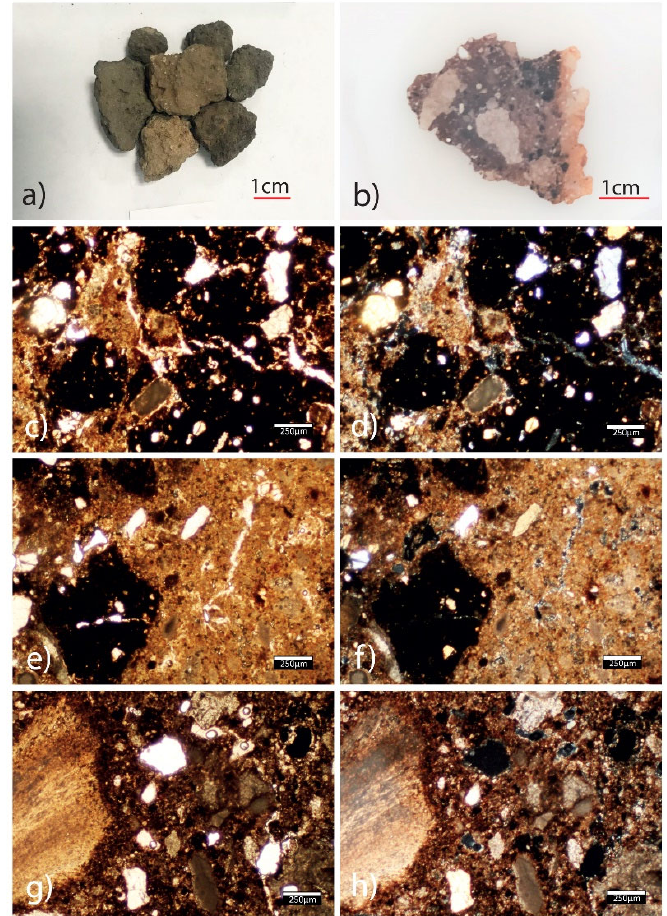
Figure 7. Sample MIN4 (Group P2a) microphotographs under polarised light microscopy (PL ‐ OM). Blackish mortar with dark and reddish cocciopesto, silicatic aggregate, limestone fragments and combustion traces. ( a ) analysed fragments; ( b ) thin section where there is a transition in the mortar between a dark area (affected by combustion processes) and a light reddish area referable to the undisturbed part of the sample; ( c ) parallel polars and ( d ) crossed polars: fragments of dark and reddish cocciopesto with quartz and feldspar microcrystals inside; ( e ) parallel polars and ( f ) crossed polars: transition in the mortar between dark area and light reddish area; ( g ) parallel polars and ( h ) crossed polars: crystal ‐ clasts of quartz, calcareous lithics and other aggregate lithic frag ‐ ment in the dark zone of mortar. In microphotos c ‐ h there are shrinkage micro ‐ cracks probably induced by a combustion.